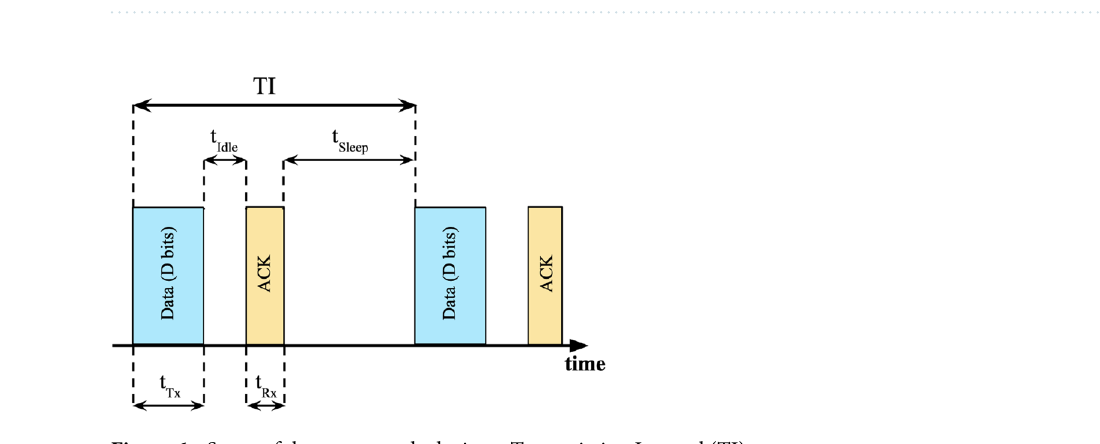
Figure 5. Comparison between the execution time of Ambrosia ’s window-based and ARIMA forecasting. The slope of the ARIMA plot is ≈ 100 × higher than that of ours.